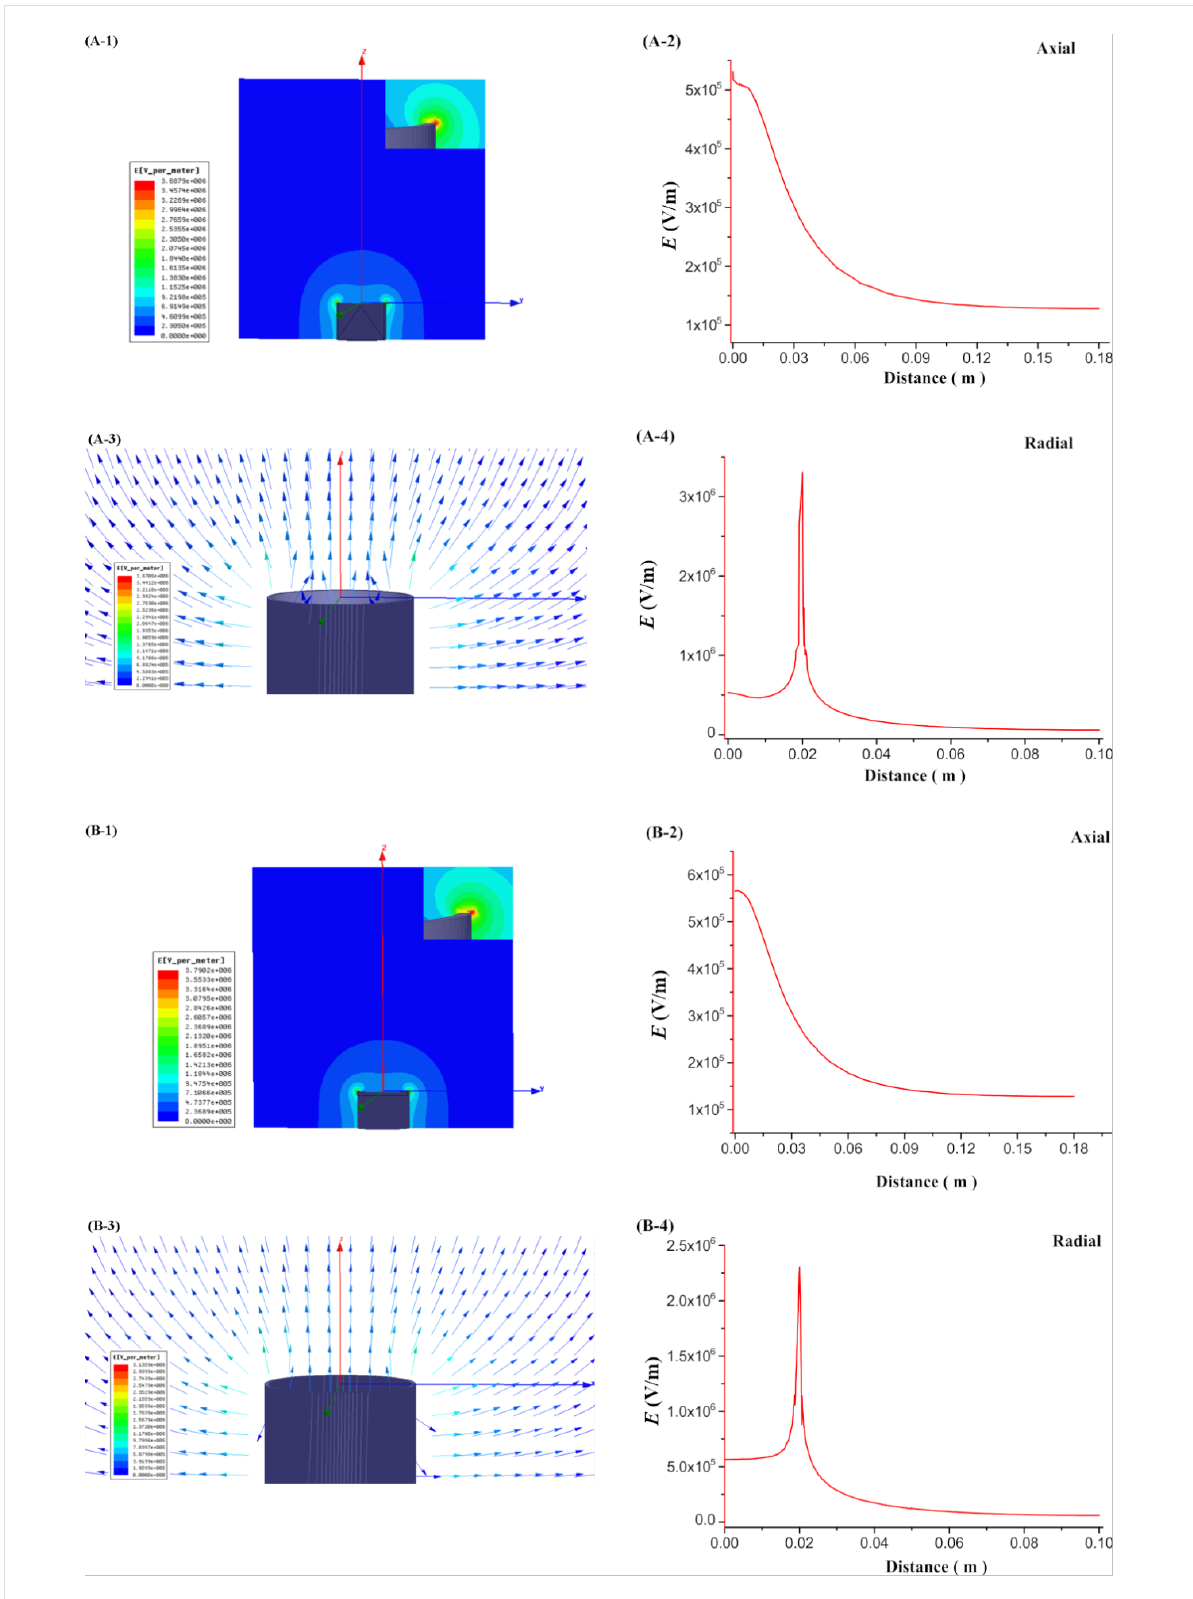
Figure 7: Simulation of the electric field in the MBE (A) and MFSE (B)